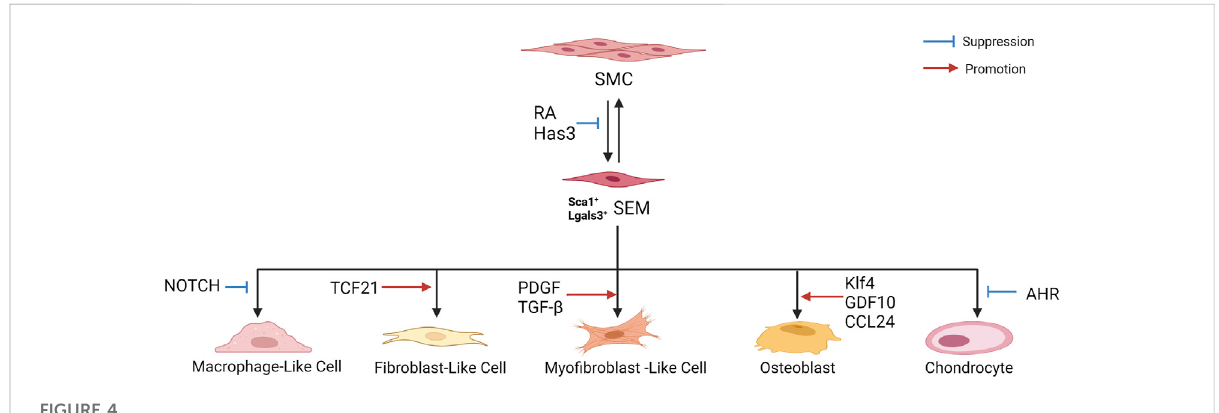
FIGURE 4 Phenotypic transition of SMCs in